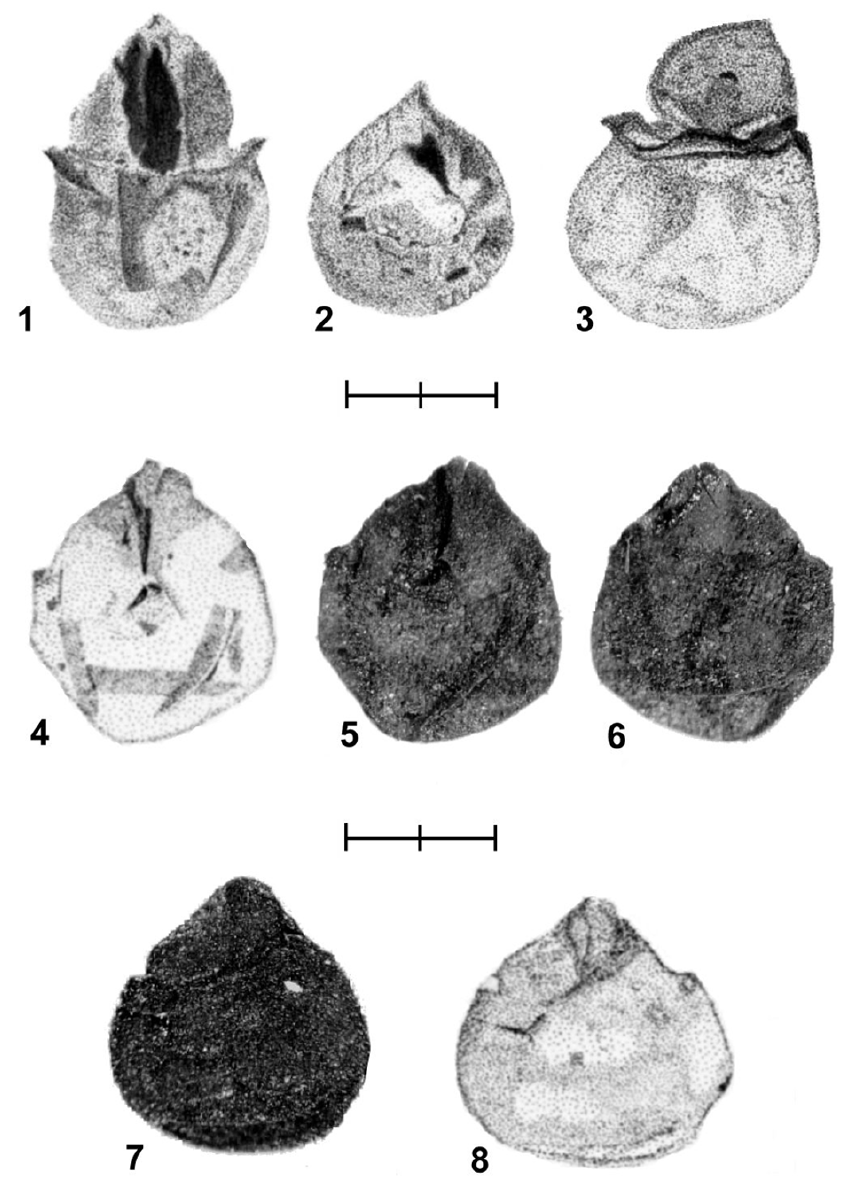
Fig. 5 – Megaspores L. triunfensis (pictures 1 and 2), L. scutiformis (picture 3), Sublagenicula cf. brasiliensis (pictures 4-6), Setosisporites cf. furcatus (pictures 7 and 8): 1. Lagenoisporites tri- unfensis , lateral compression. (GP/3T 2189); 2. Lagenoisporites triunfensis , polar compression, proximal view (GP/3T 2204); 3. Lagenoisporites scutiformis , distal view in lateral compression (GP/3T 2182); 4. Sublagenicula cf. S. brasiliensis , lateral compression (GP/3T 2147); 5. Subla- genicula cf. S. brasiliensis , oblique proximal view; 6. Sublagenicula cf. S. brasiliensis , oblique distal view; 7. Setosisporites cf. S. furcatus , lateral compression (GP/3T 2147); 8. Setosisporites cf. S. furcatus , lateral compression. Scale bar: 1mm.